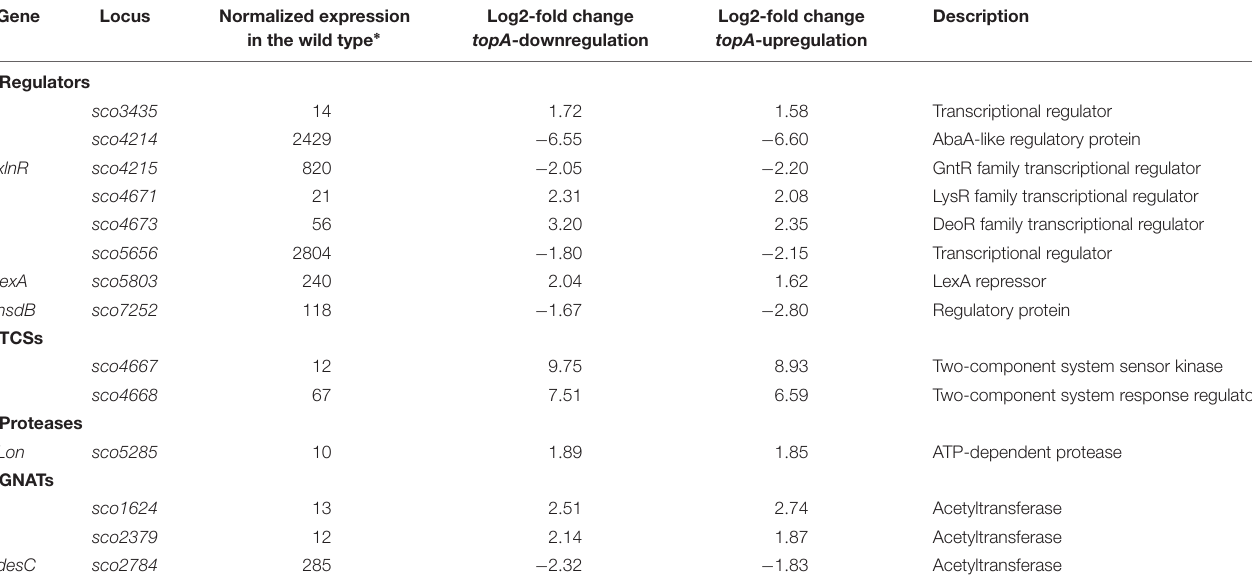
TABLE 4 | The regulators encoding genes affected by both constitutive topA -downregulation and topA -upregulation (based on RNA-Seq data; log2-fold > 1.5; p < 0.05). Gene Locus Normalized expression